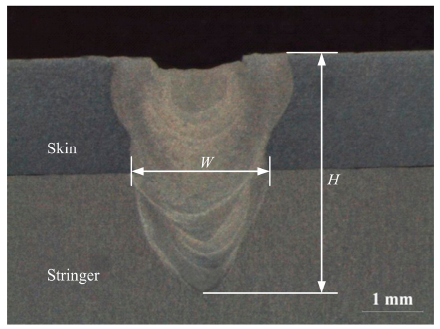
Figure 4. Definitions of the geometric dimensions of the weld morphology.